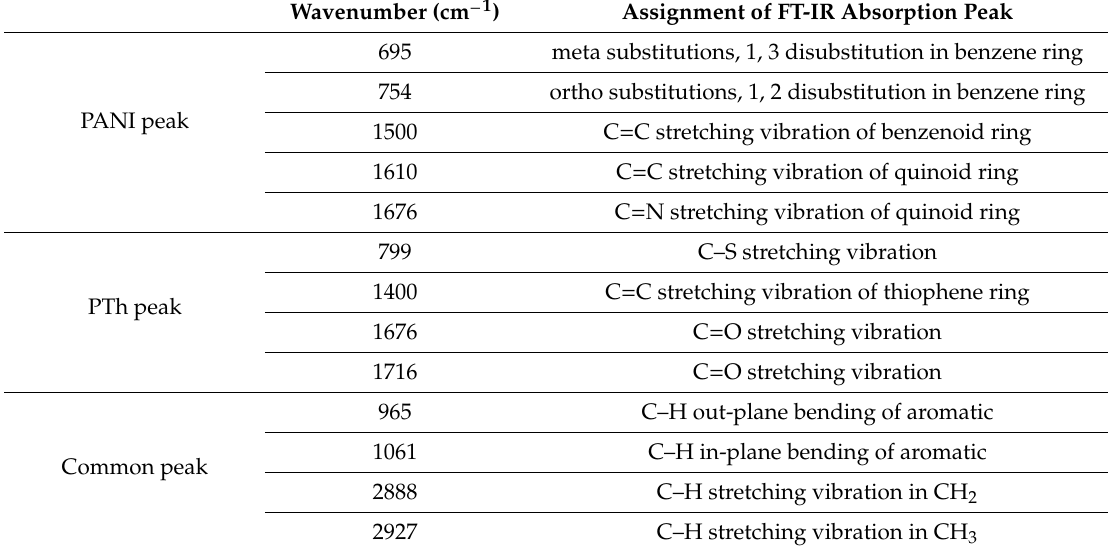
Table 2. Absorption peaks of FT-IR for molecular structures of TAC films deposited on glass substrate relative to various ratios of blended solutions of aniline and thiophene monomers.